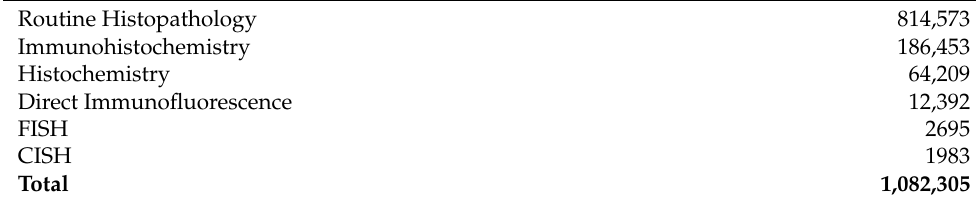
Table 1. Number of slides in